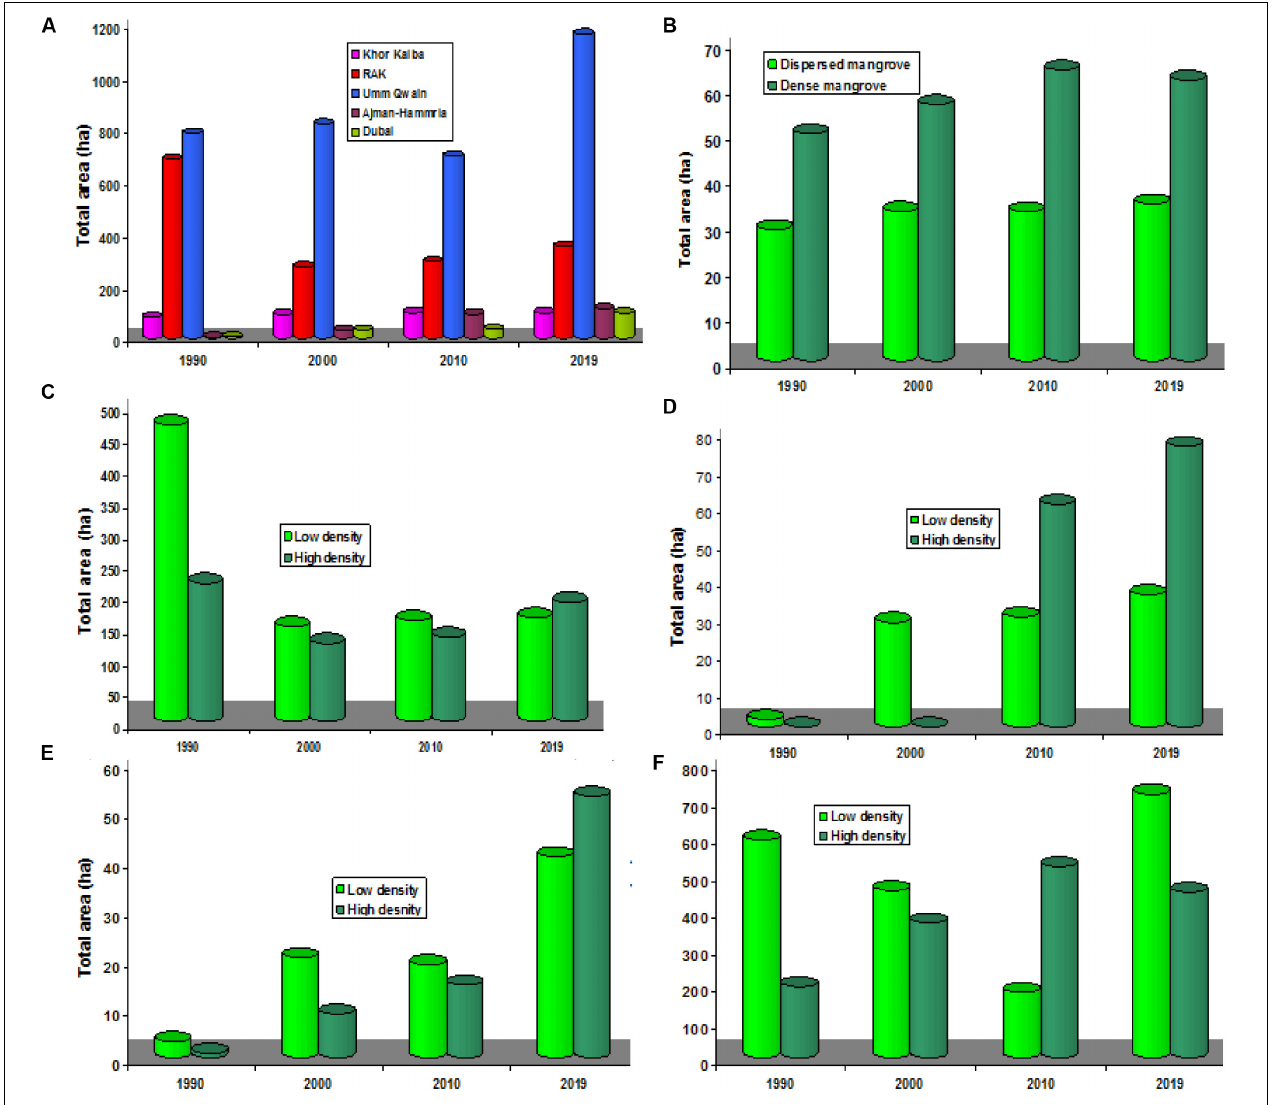
FIGURE 11 | The annual rate of the NUAE mangroves growth (A) , and mangrove types for Khor Kalba (B) , RAK (C) , Ajman-Hammriah (D) , Ras Al Khor (E) , and Umm Al Quwain (F) .